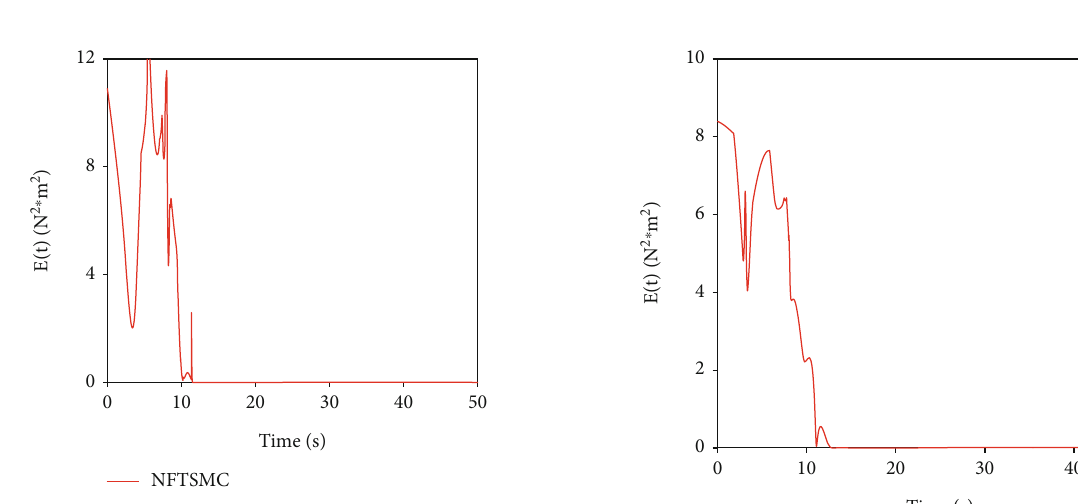
Figure 7: Time response of energy consumption in Ref. [24].